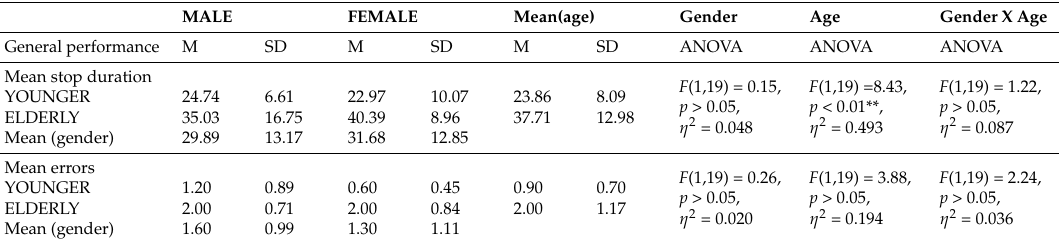
Figure 11. AOI for self-location: the red point is the area of interest. Table 8. Descriptive and inferential statistics for Task 3 (route